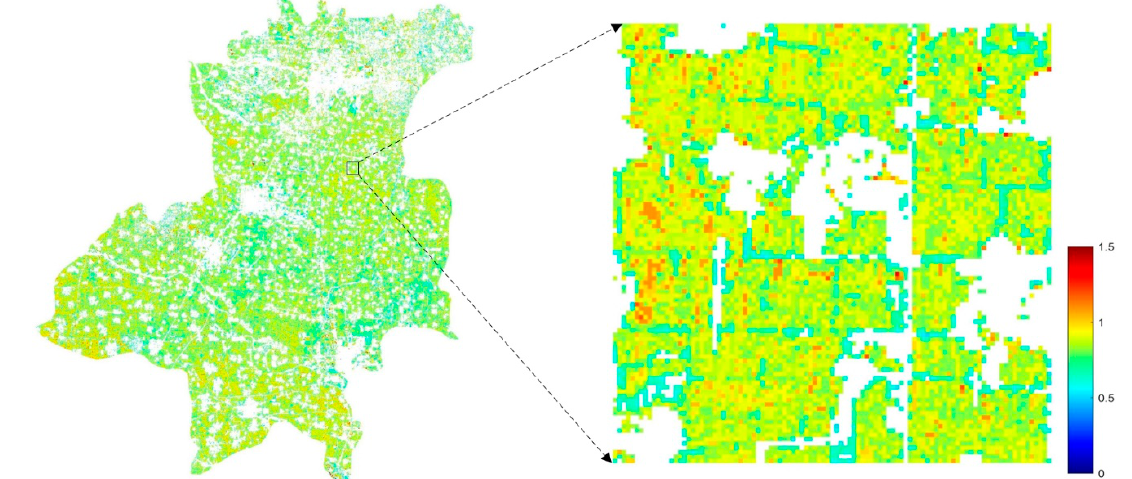
Figure 9. LAI bias (m 2 /m 2 ) between the retrieved LAI with and without inferred leaf angle distribution function on 4 September 2014.